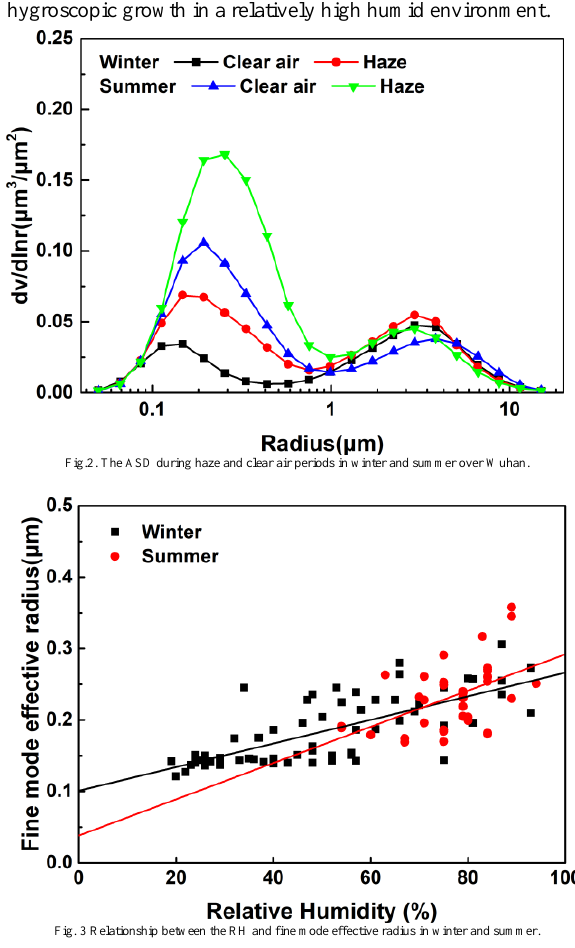
Fig. 3 Relationship between the RH and fine mode effective radius in winter and summer.